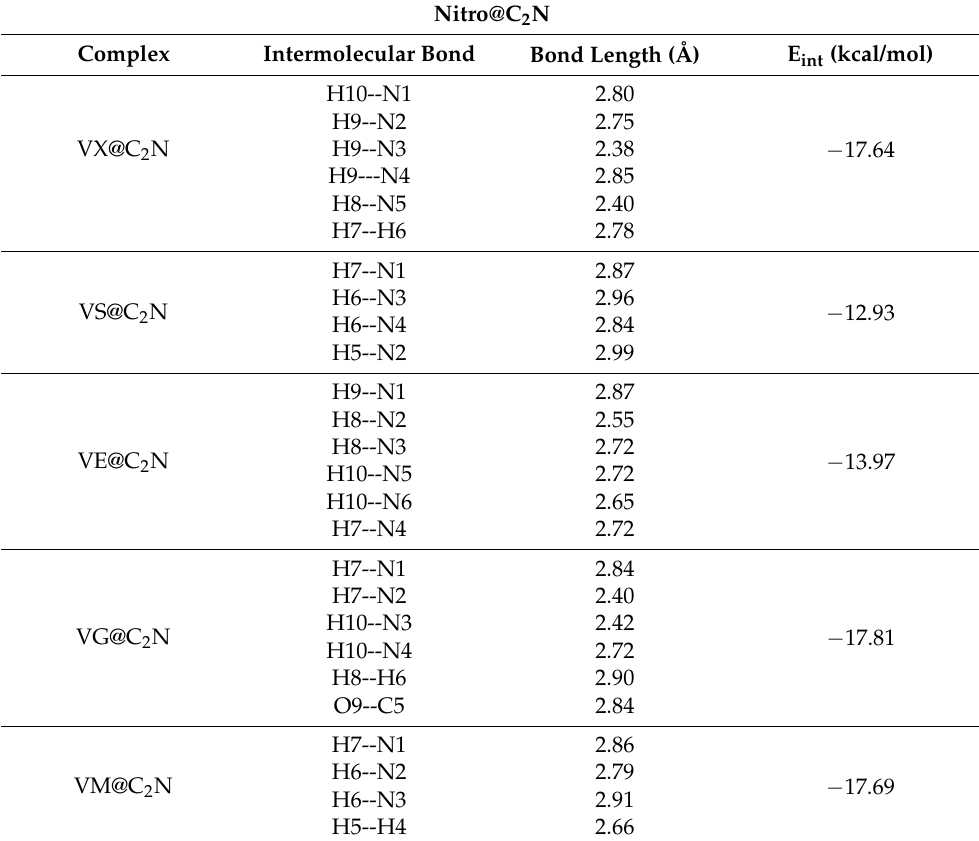
Table 1. Bond lengths (Å) and interaction energies (kcal/mol) of the V-series@C 2 N complexes at the M05-2X/ 6-31++G(d,p) level of